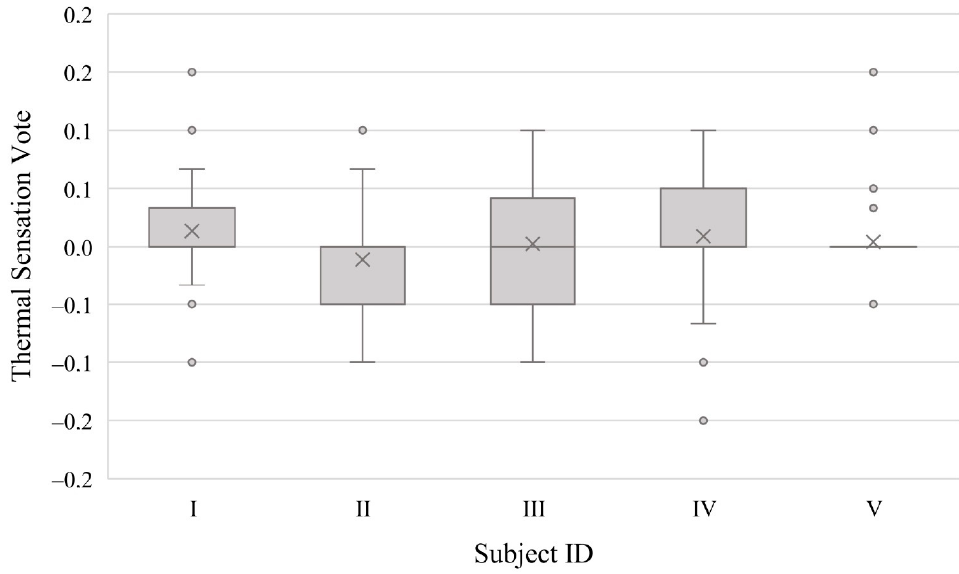
Figure 3. Thermal sensation of each subject, where the “x” represents the median, the points are the outliers, the box shows the interquartile range, and the bars demonstrate maximum and minimum calculated values within the sample.